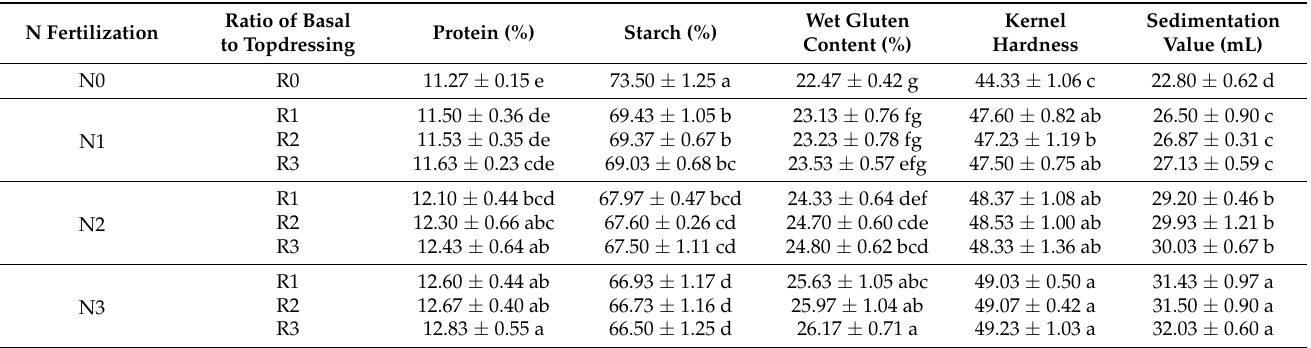
Table 3. Effects of nitrogen application method on grain quality (average value of 2019, 2020 and 2021) of wheat.